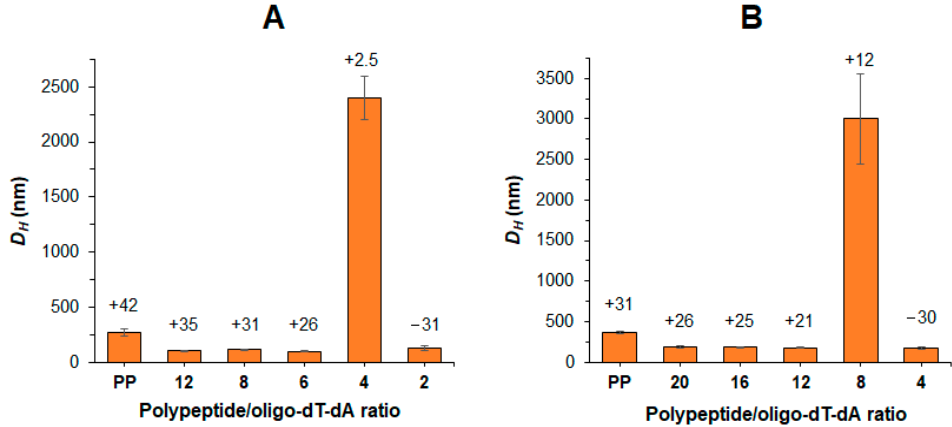
Figure 3. E ff ect of polypeptide/oligo-dT-dA ratio on D H and ζ -potential (above the bars) for the complexes based on P[KK( Y )K( R )] ( A ) and P[KK( Y )K( H )] ( B ) (PP is non-loaded polypeptide particles).